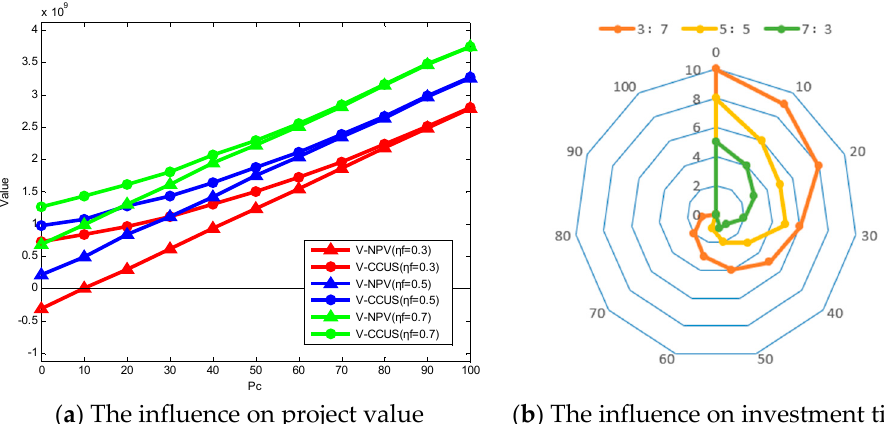
Figure 7. The impact of the carbon utilization method on the NPV and investment value of CCUS.